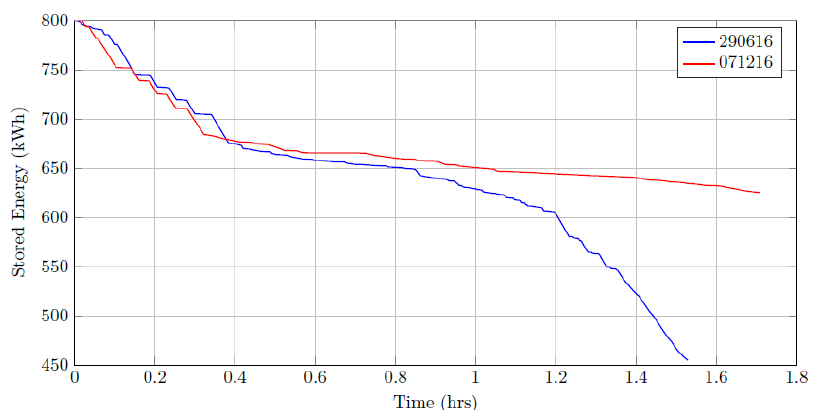
Figure 16. Energy state of an 800 kWh battery for 29.06.16 and 07.12.16 datasets using battery only.